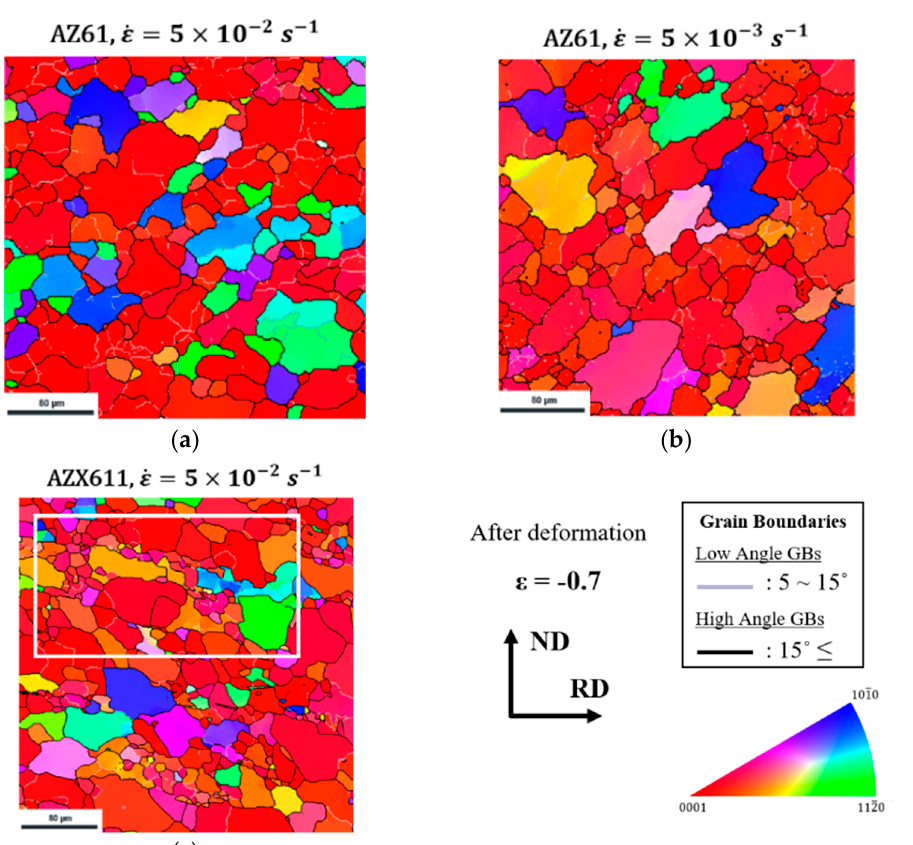
Figure 5. Microstructures of the TD planes of ( a ), ( b ) AZ61 and ( c ) AZX611 specimen TD plane after deformation strain up to − 0.7 in each strain rate.